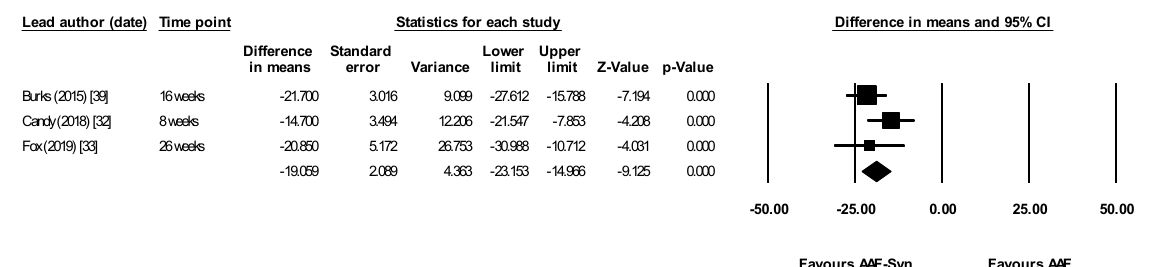
Figure 4. Meta-analysis showing significantly higher percentages of faecal bifidobacterial species with AAF-Syn. Abbreviations: AAF-Syn: amino acid formula with synbiotics. AAF: amino acid formula. CI: confidence intervals.